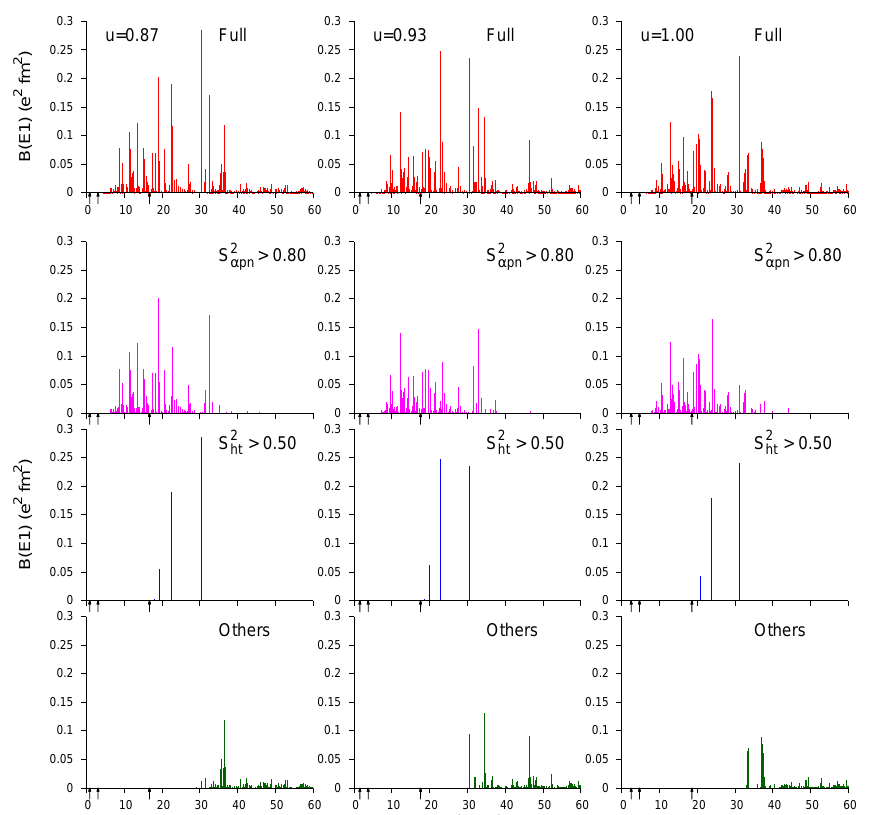
Figure 2: Electric-dipole transition strengths and their decomposition with respect to the spectroscopic factors. The parameters u = 0.87,0.93 and 1.00 in the MN interaction are employed. Arrows indicate the theoretical threshold energies of α + d , α + p + n , and h + t from left to right, respectively. The results with u = 0.93 and the Full calculations are adopted from Ref. [ 3 ]